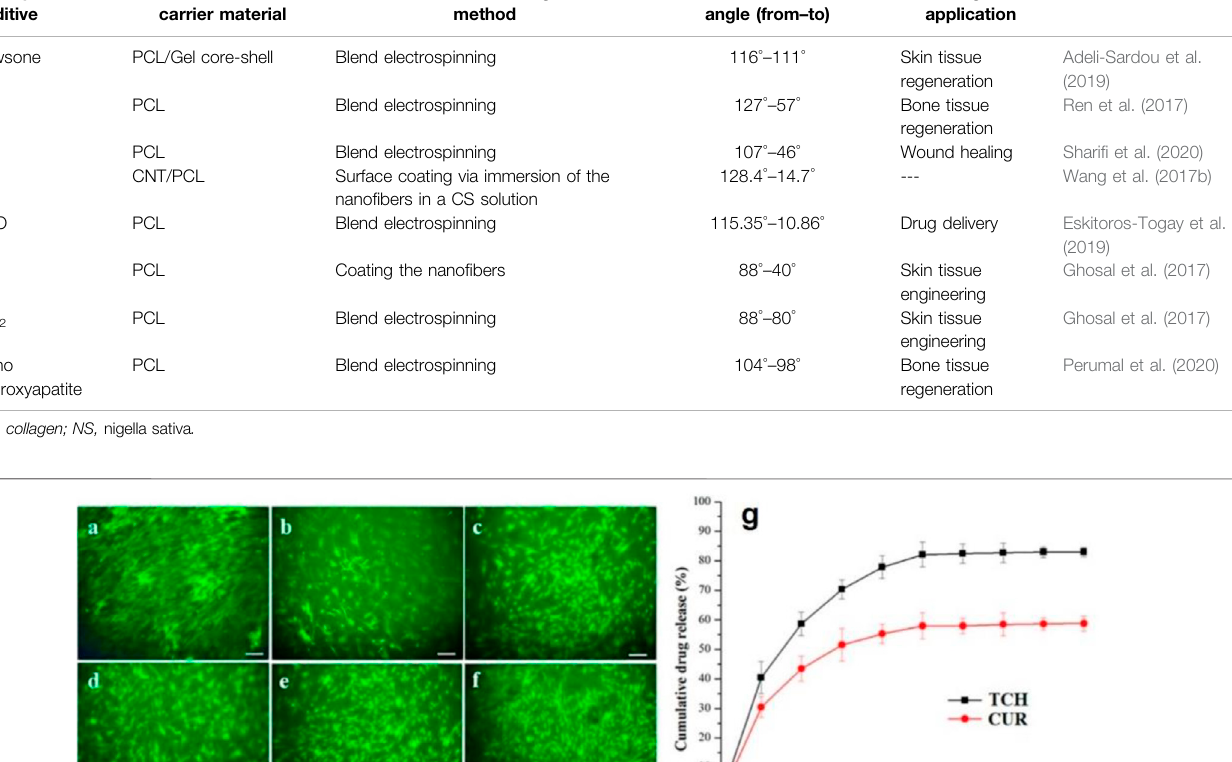
TABLE 2 | Hydrophilized PCL-based nano fi bers for biomedical applications (studies reported after 2017). Hydrophilic additive